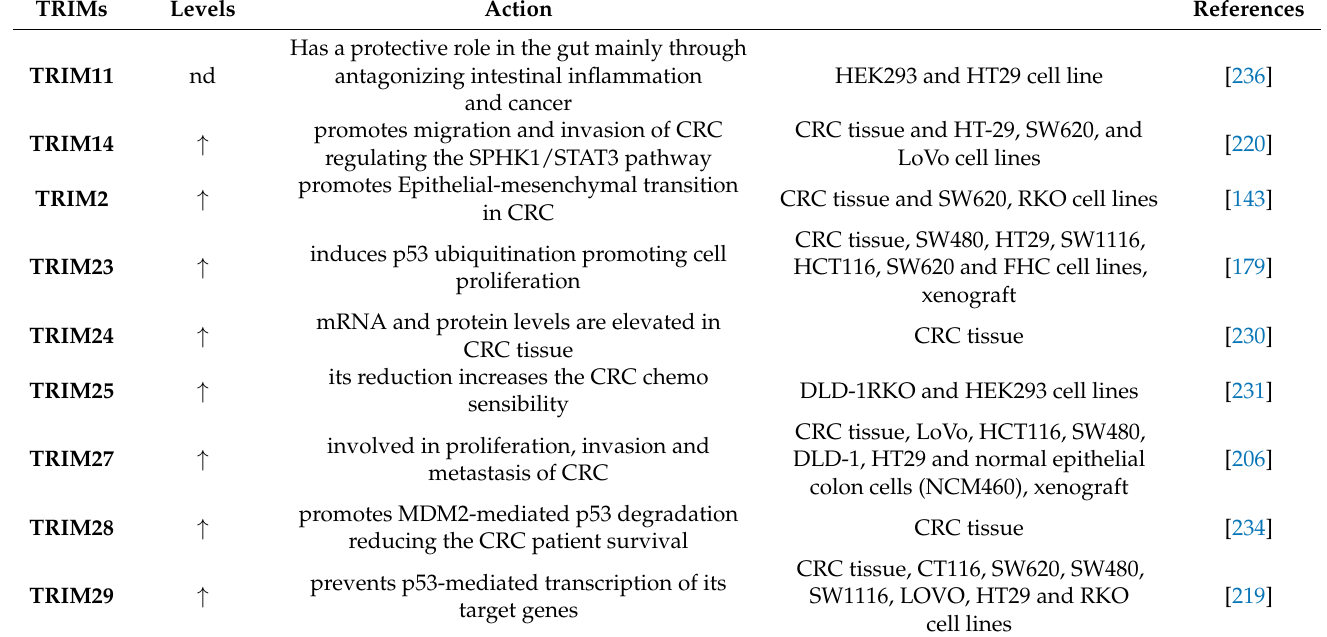
Table 2. TRIM proteins involved in CRC. Tripartite motif (TRIM) proteins described in the manuscript are listed based on their expression levels in different types of cancer, also below is indicated where the TRIM gene expression levels or mechanisms of action were obtained. The arrows indicate if that TRIM protein was found up- ( ↑ ) or down- ( ↓ ) regulated; nd indicates not detected